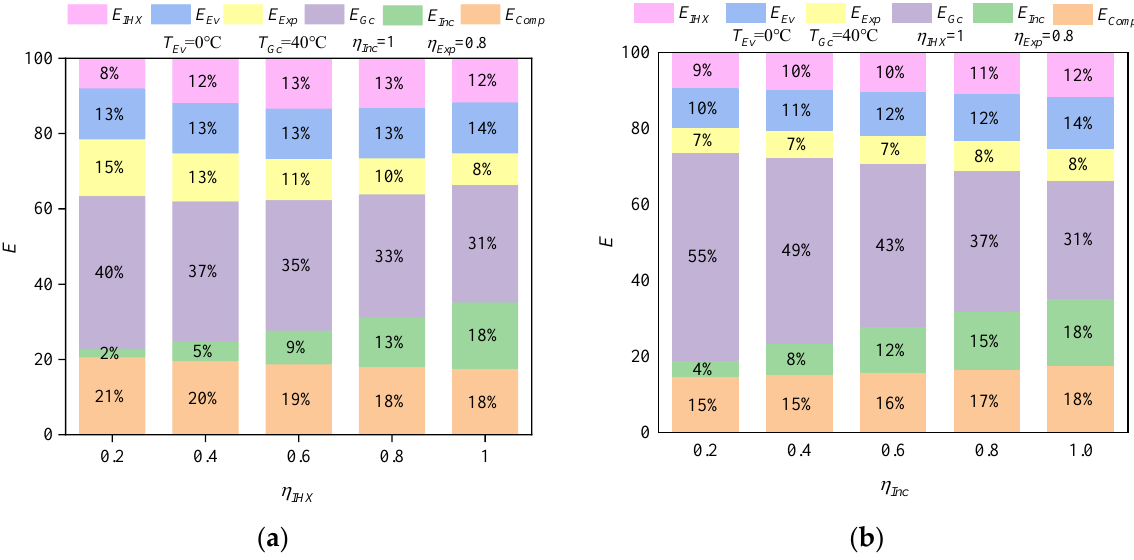
Figure 14. Effect of efficiency of heat exchanger on the system’s exergy loss: ( a ) The effect of η IHX on exergy loss with Inc; ( b ) The effect of η Inc on exergy loss with IHX .